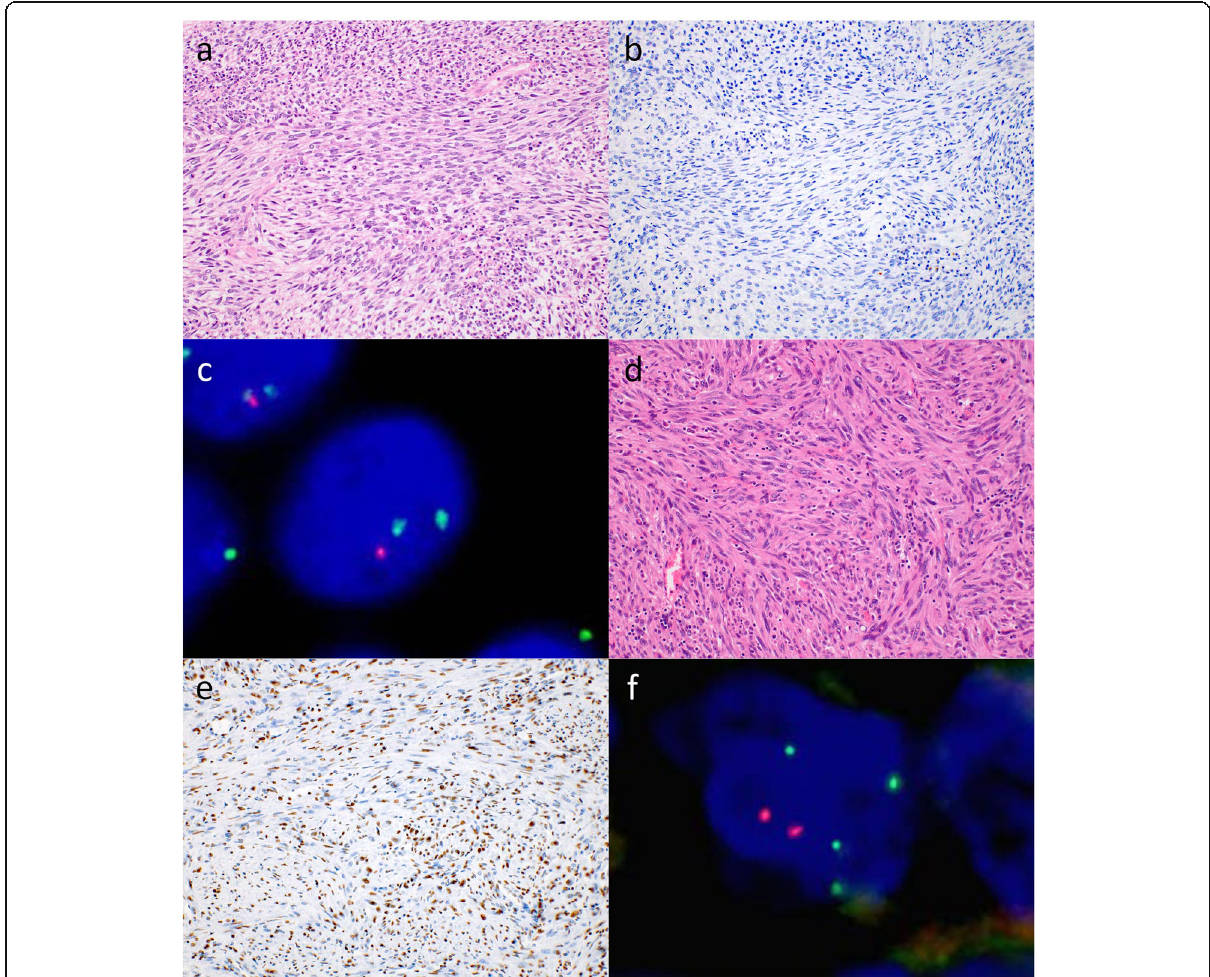
Fig. 1 Pathological findings including morphology, immunohistochemistry (IHC), and fluorescence in situ hybridization (FISH) of malignant peripheral nerve sheath tumor (MPNST) cases. a . MPNST with fascicular proliferation of spindle cells that had enlarged oval to spindle nuclei with moderate to severe nuclear atypia (NF1M-20). b . IHC for histone 3 trimethylated on lysine 27 (H3K27me3). The tumor cells were completely negative for H3K27me3 on IHC (NF1M-20). c . FISH for p16 deletion. The tumor nuclei showed heterozygous deletion of p16 . Two green signals indicating a control locus and one red signal indicating a target locus were found (NF1M-20). d . Another case of MPNST also exhibited fascicular and storiform proliferation of spindle cells with enlarged spindle nuclei with moderate to severe nuclear atypia (NF1M-6). e . IHC for H3K27me3. A majority of tumor cells were positive for H3K27me3 on IHC, although H3K27me3-negative tumor cells were focally intermingled. The tumor showed partial loss of H3K27me3 (NF1M-6). f . FISH for neurofibromatosis 1 ( NF1 ) deletion. Tumor nuclei showing heterozygous deletion of NF1 . The number of red signals (two) for the target locus was less than the number of green signals (four) for the control locus